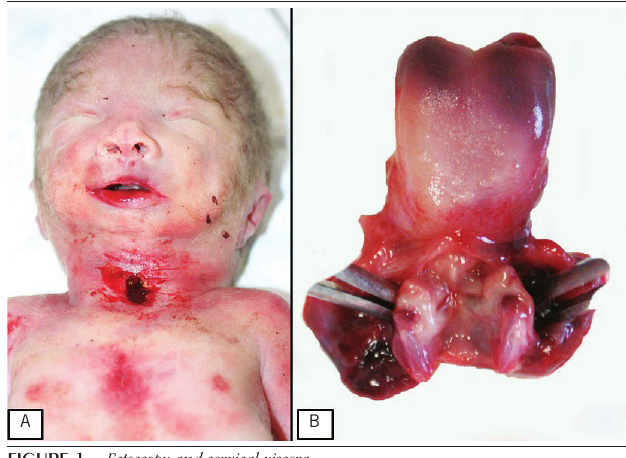
figuRE 1 − Ectoscopy and cervical viscera A) ectoscopy shows micrognathism: facial contours in the mandibular region are depressed; B) cervical viscera: posterior displacement of the tongue, compressing the vallecula, structurally compatible with glossoptosis.